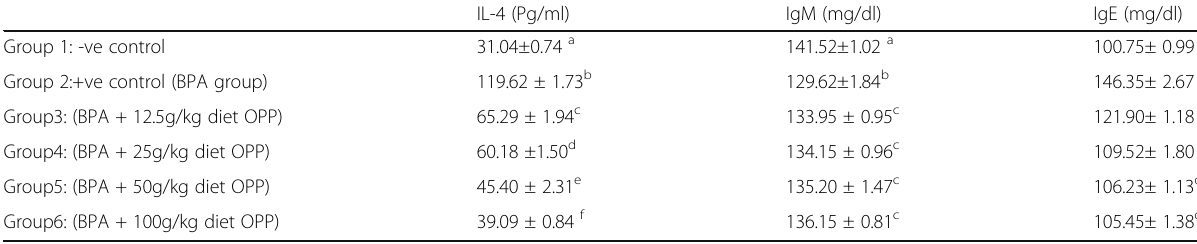
Table 3 The effect of orange peel powder on serum IL-4, IgM, and IgE levels in BPA-treated rats IL-4